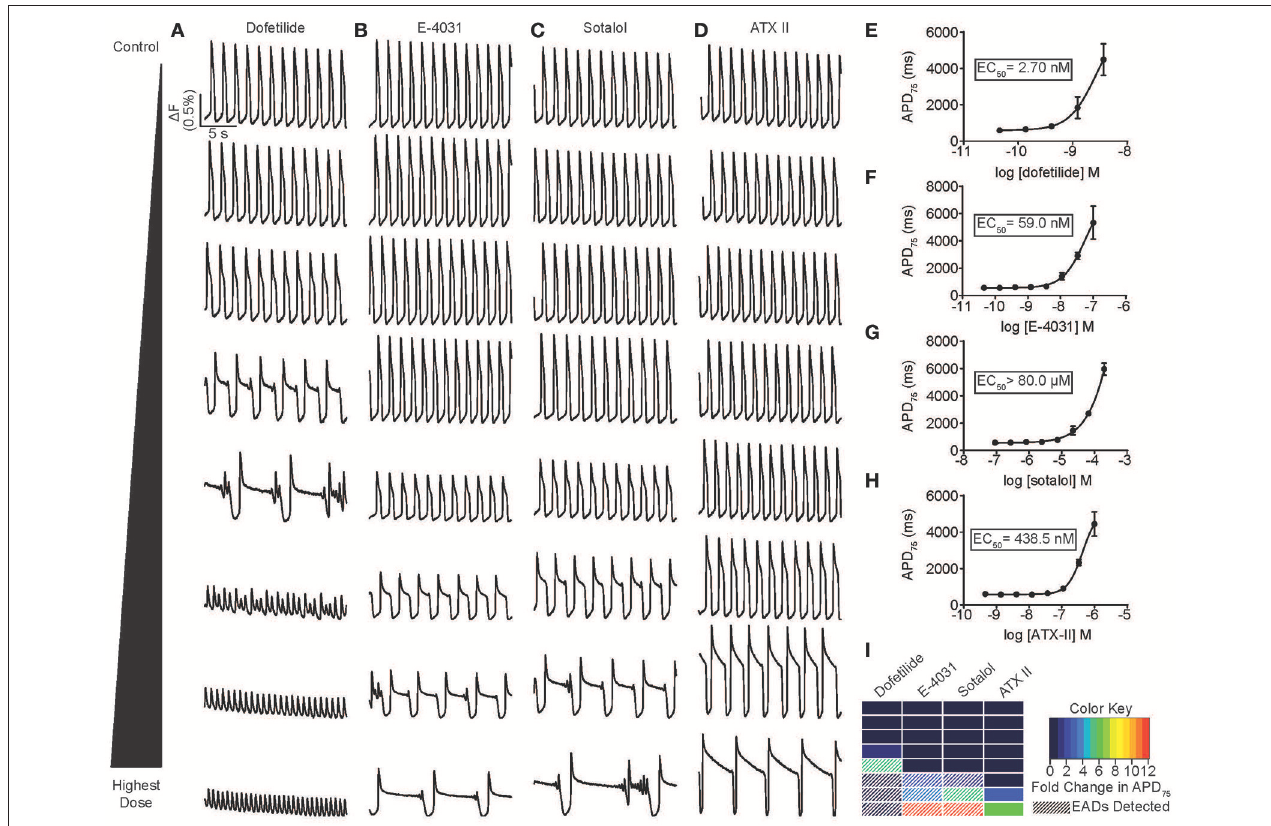
FIGURE 3 | Automated high throughput characterization of drug-induced arrhythmias. (A–D) Representative 1 F/F 0 vs. time plots (33Hz) for a dose response with dofetilide (0.1–100 nM) (A) , E-4031 (0.1–100 nM) (B) , sotalol (0.2 –200 µ M) (C) , and ATX-II (1–1,000 nM) (D) in normal individual (iCell) hiPSC-CMs. (E–H) Dose response curve for APD 75 for dofetilide (A) , E-4031 (B) , sotalol (C) , and ATX-II illustrating a dose dependent prolongation of the APD and an EC 50 values of 2.7, 59nM, > 80 and > 200 µ M, respectively. Each point represents an individual well, n = 3. Error bars are s.e.m. (I) A heat map illustration the magnitude of prolongation and automated detection of EADs for an 8-point dose range for dofetilide, E-4031, sotalol, and ATX-II. Automated detection of EADs signified by white stripes. Scale bars indicate time (5s) and 1 F (0.5% of the value in each well).